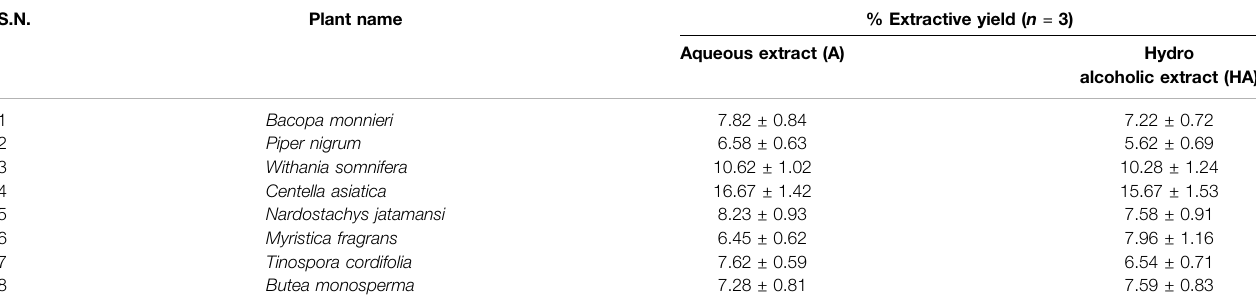
TABLE 2 | Extractive values of selected plant extracts. S.N.